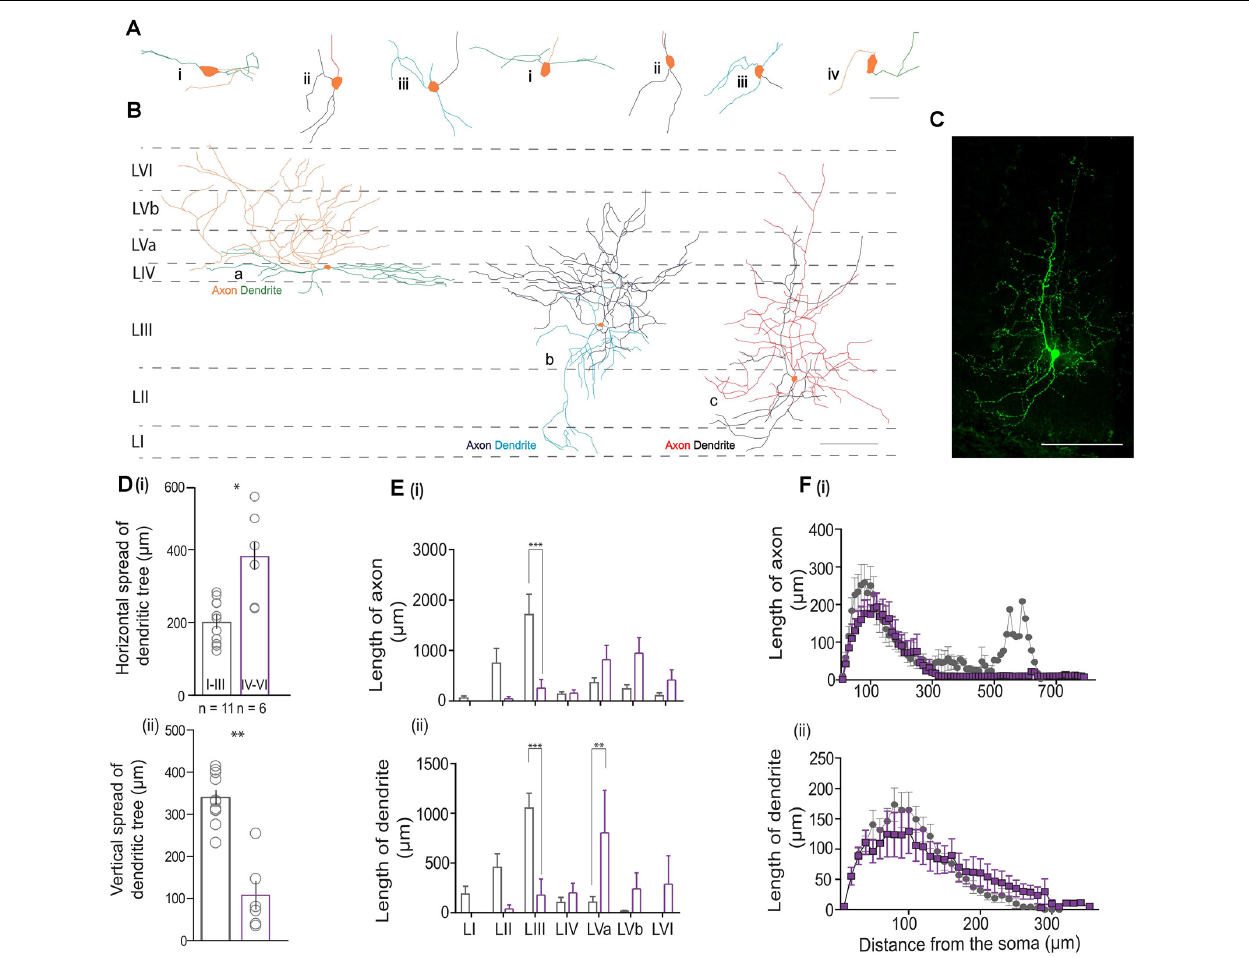
FIGURE 5 | Morphometric analysis of VIP cells. (A) Magnified views of the somatodendritic and axonal processes representing the following morphologies: i—horizontal bitufted, ii—vertical bitufted, iii—multipolar, and iv—unipolar architectures. The scale bar is 50 µ m. Please note that in (A) (ii—right), the axon originates from a primary dendrite. (B) Schematic of the MEC with neurolucida reconstructions depicting the three predominant morphologies observed in the data; horizontal bitufted in L4 (a; axons in orange, dendrites in green), multipolar VIP neuron in LIII (b; axons in dark blue and dendrites in light blue), and vertical bitufted morphology seen in L2 (c; axons in red, dendrites in blue). Scale bars are 100 µ m. For all cells, the soma is colored in orange. (C) Maximum projection intensity of 207 z-stacks of 0.5 µ m depth taken in 20x magnification of reconstruction seen in (B) (c) of the MEC filled with neurobiotin (GFP). Scale bar is 100 µ m. (D) Plots depicting the (i) vertical and (ii) horizontal spread of the dendritic process. Each bar represents a mean and SEM. (E) Graphs assessing the length of processes present in a specific layer for (i) axons and (ii) dendrites. Each bar represents a mean and SEM. (F) Morphological features of (i) axons and (ii) dendritic arbors obtained from Sholl analysis. Each bar represents a mean and SEM. For all graphs, LI–III = 11 cells, LIV–VI = 6 cells: ∗∗∗ p < 0.001, ∗∗ p < 0.01, ∗ p <